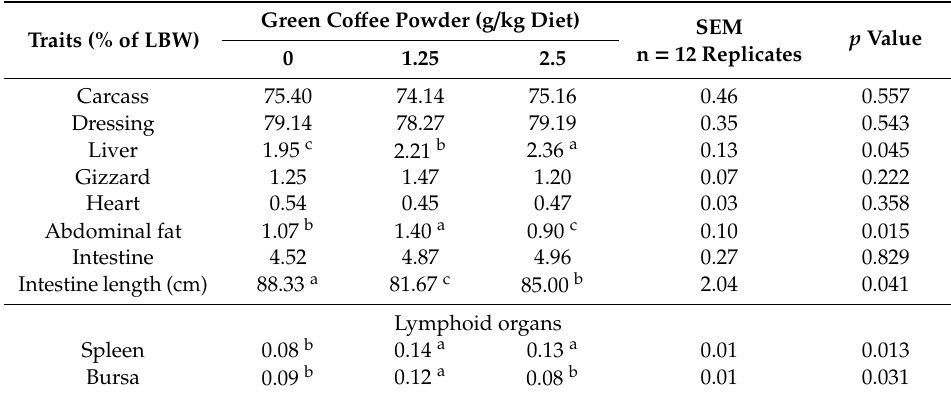
LBW:livebodyweight. Meanwithdi ff erentletterswithinonerowaresignificantlydi ff erent( p < 0.05). SEM:standard error of mean.